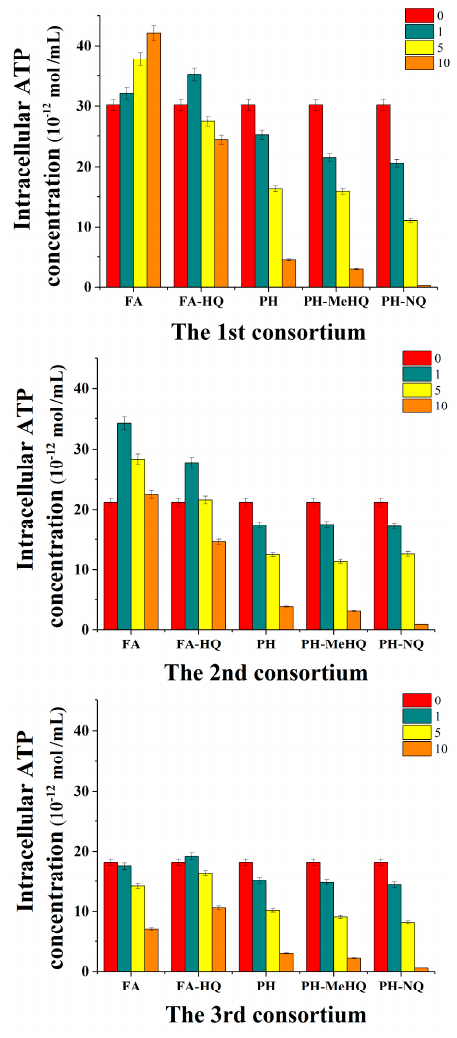
Figure 5. Influence of di ff erent concentrations of HC (g / L) on the intracellular ATP concentration in cell samples after anaerobic cultivation of methanogenic consortia.